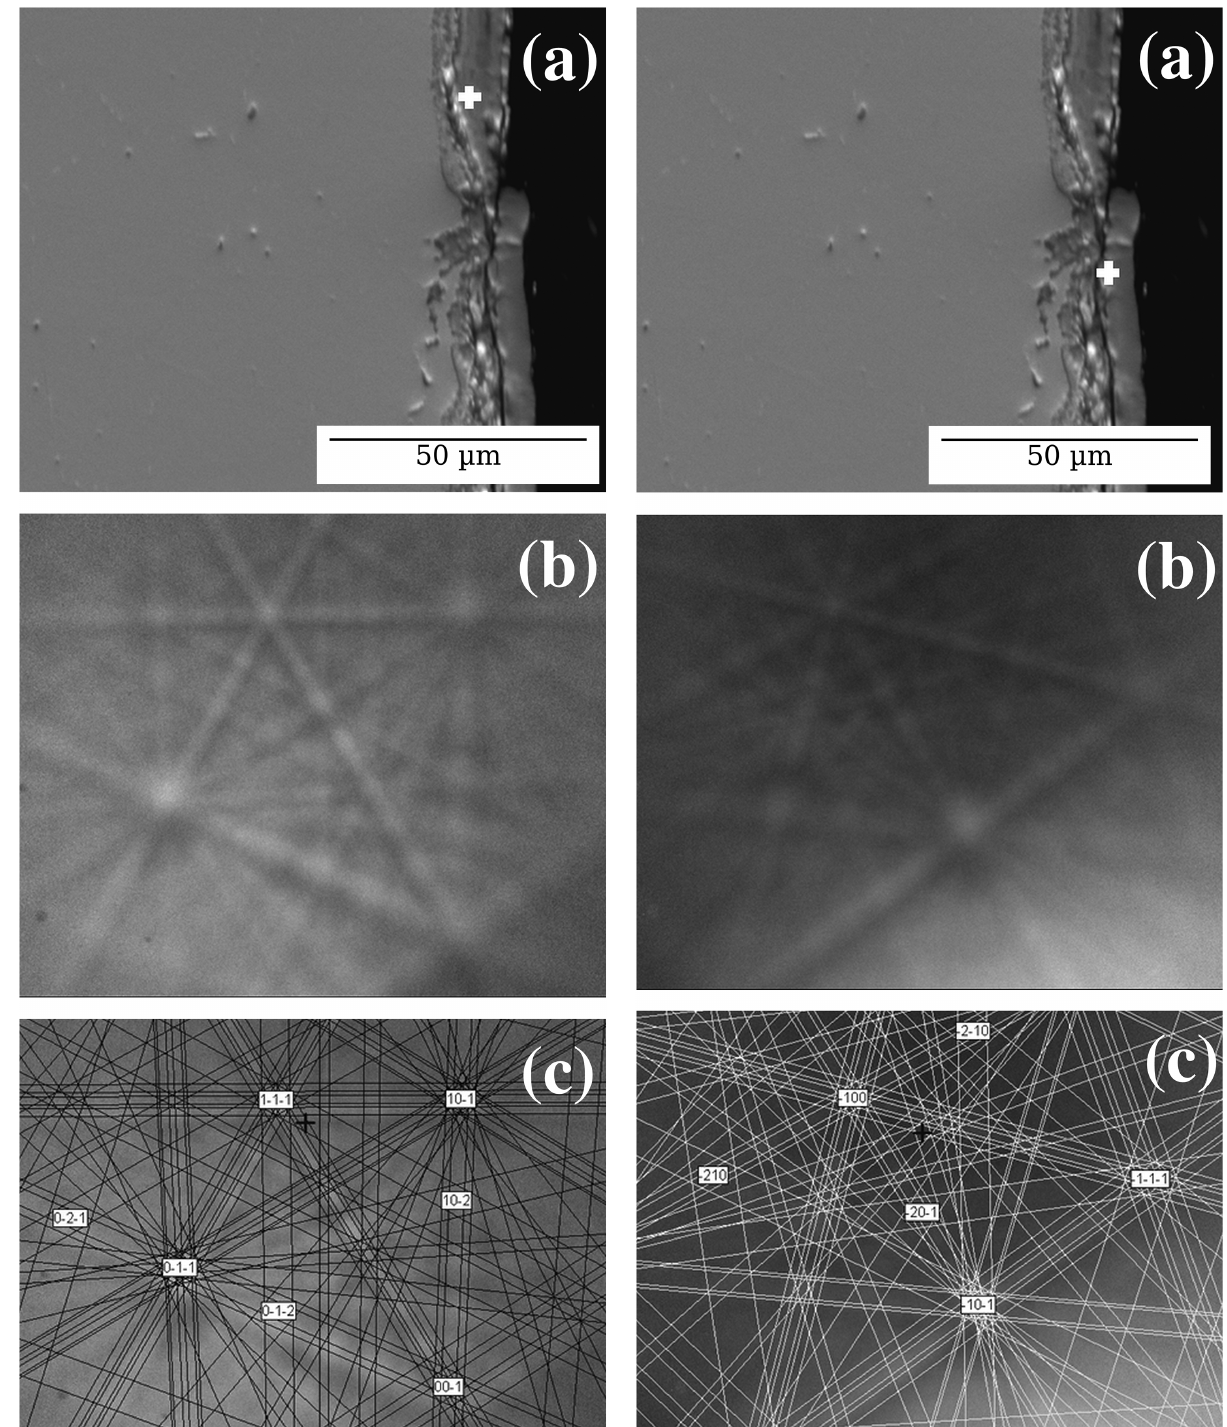
Figure 9: The results of EBSD analysis of the external part of the oxide scale growing on the surface of the X2CrNiMo17-12-2 steel sample (a) cross-section of oxidized steel sample with marked micro-region, in which the EBSD analysis has been performed (b) an electron backscatter diffraction pattern (c) results of simulation of indexed planes for crystalline Fe 3 O 4